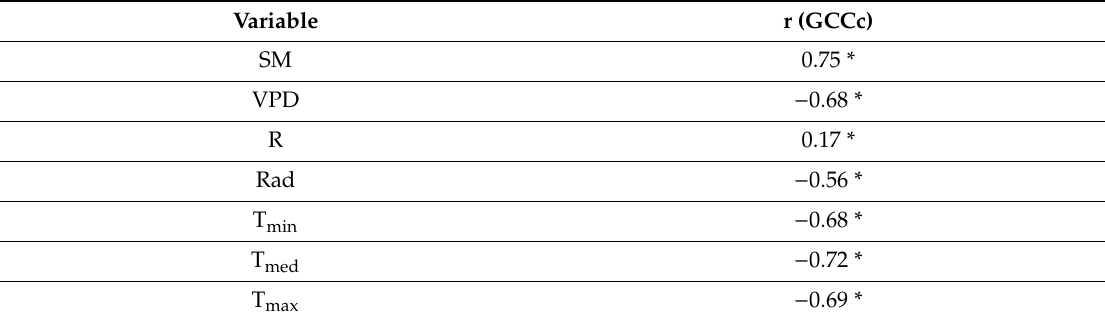
Table 4. Pearson correlation matrix between GCCc data and the abiotic variables at a daily scale. * p <